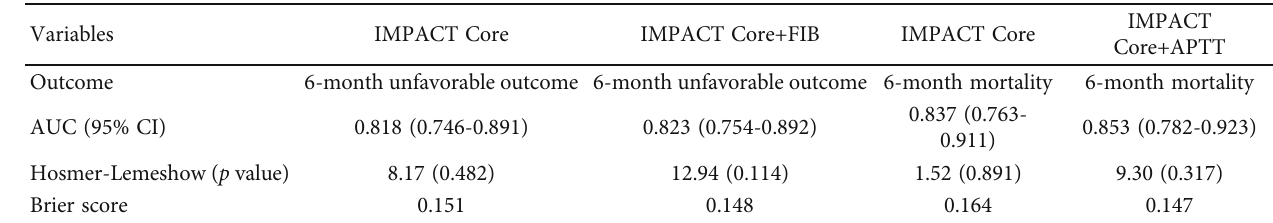
Table 6: Validation of models.